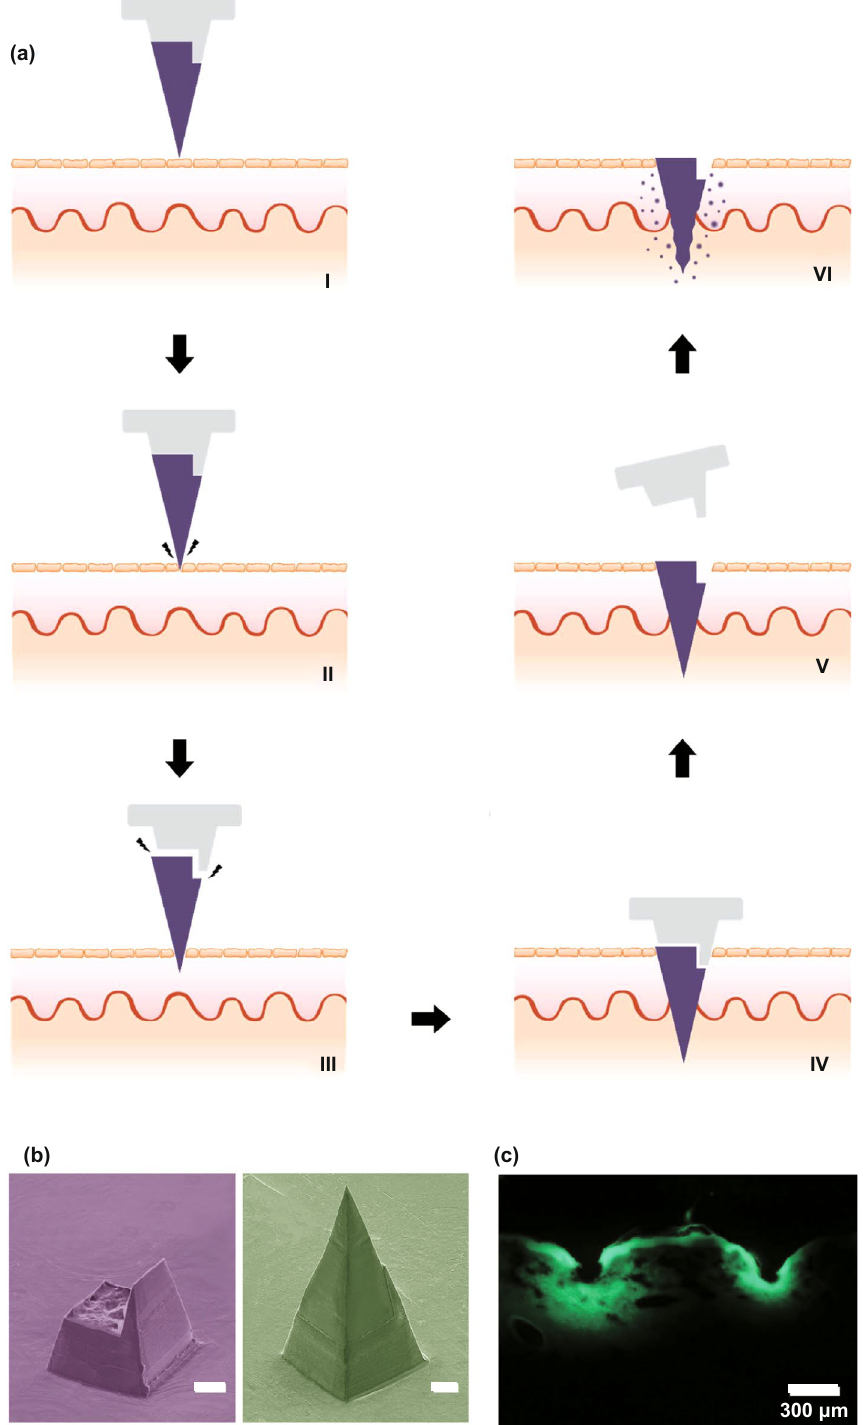
Fig. 15 a I– a VI Insertion-responsive MNs, which use two different materials to form the MN base and MN tips. Upon skin insertion, separation of the tip from the rest of the MN occurs immediately and the tip remains embedded within skin tissue, and the rest of the MN is removed from the skin, allowing the inserted tip to slowly release the drug [197]. b SEM images of an a single-walled stand (left), and an insertion-responsive MN with a single-walled stand (right). Scale bar = 100 µm. c Cross sections of porcine skin following insertion-responsive MN insertion. MNs were loaded with fluorescein as a model drug. Scale bar = 300 µm. Reprinted from Ref. [197] with permission from Royal Society of